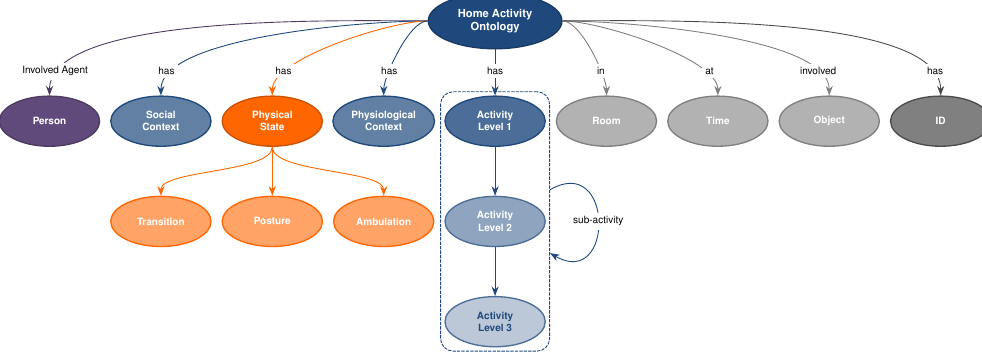
Figure 1. High-level view of ADL